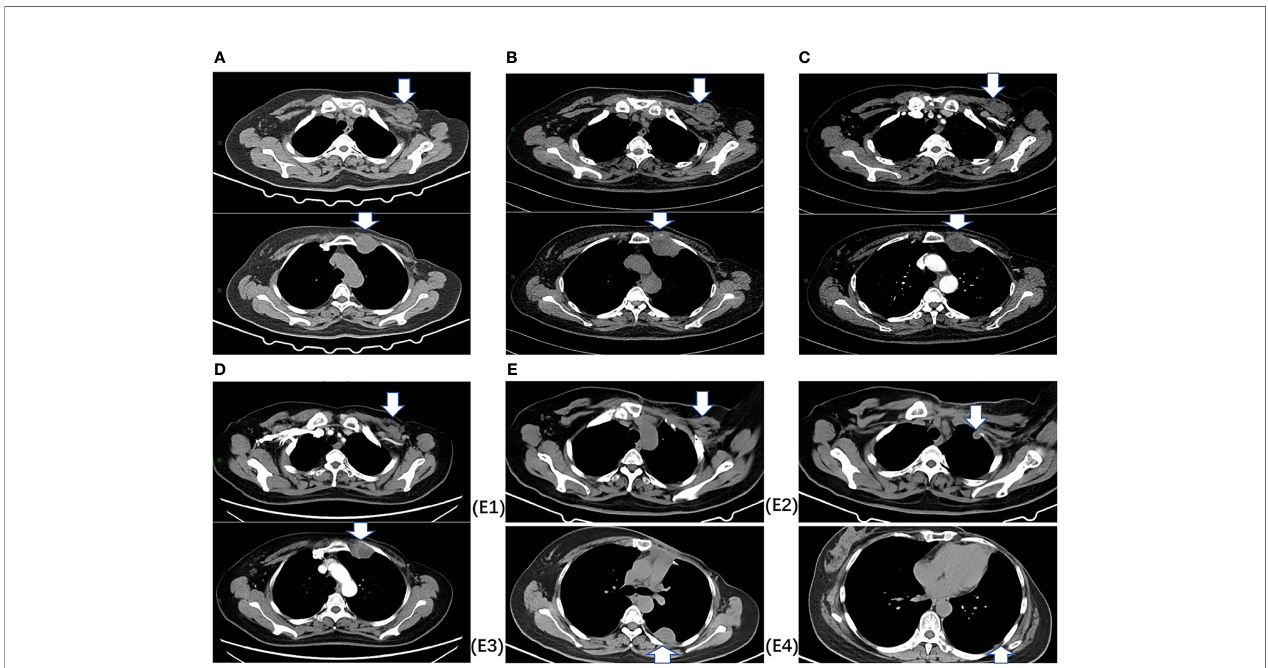
FIGURE 1 | Chest CT images. (A) At baseline (July 2020), CT indicated a 2.7 cm×1.7 cm nodule in the left interpectoral region, and a 3.5 cm×3.0 cm mass in the left internal mammary area. (B) After two cycles of chemotherapy (September 2020), CT indicated stable disease (SD) with a decreased nodule size (2.4×1.5 cm) and a slight increase in the mass size (4.5×3.3 cm). (C) After four cycles of chemotherapy (November 2020), CT indicated SD with a decreased nodule size (2.2×1.2 cm) and mass (4.4×3.1 cm). (D) After six cycles of chemotherapy (February 2021), CT indicated SD with a decreased nodule size (1.5×0.7 cm) and mass (3.6×3.1 cm). (E) After surgery, E1 shows the left interpectoral node shrinkage to 1.2×0.8 cm in size, and E2, E3, E4 show appearance of multiple left pleural metastatic